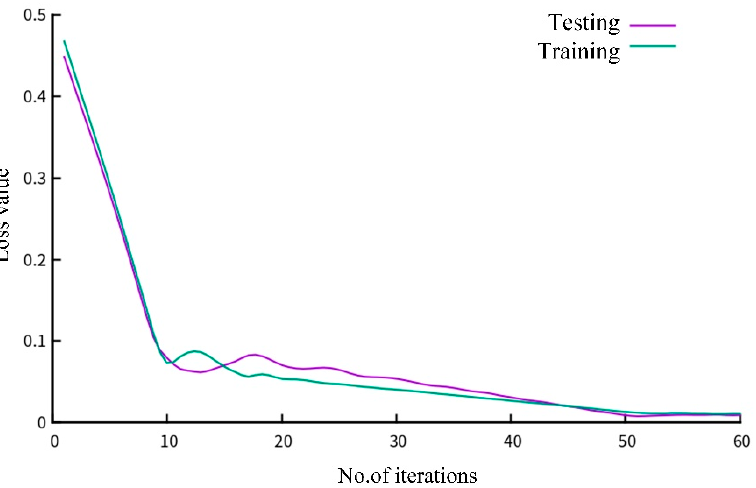
Figure 7. Loss comparison between testing and training dataset of LSTM model.